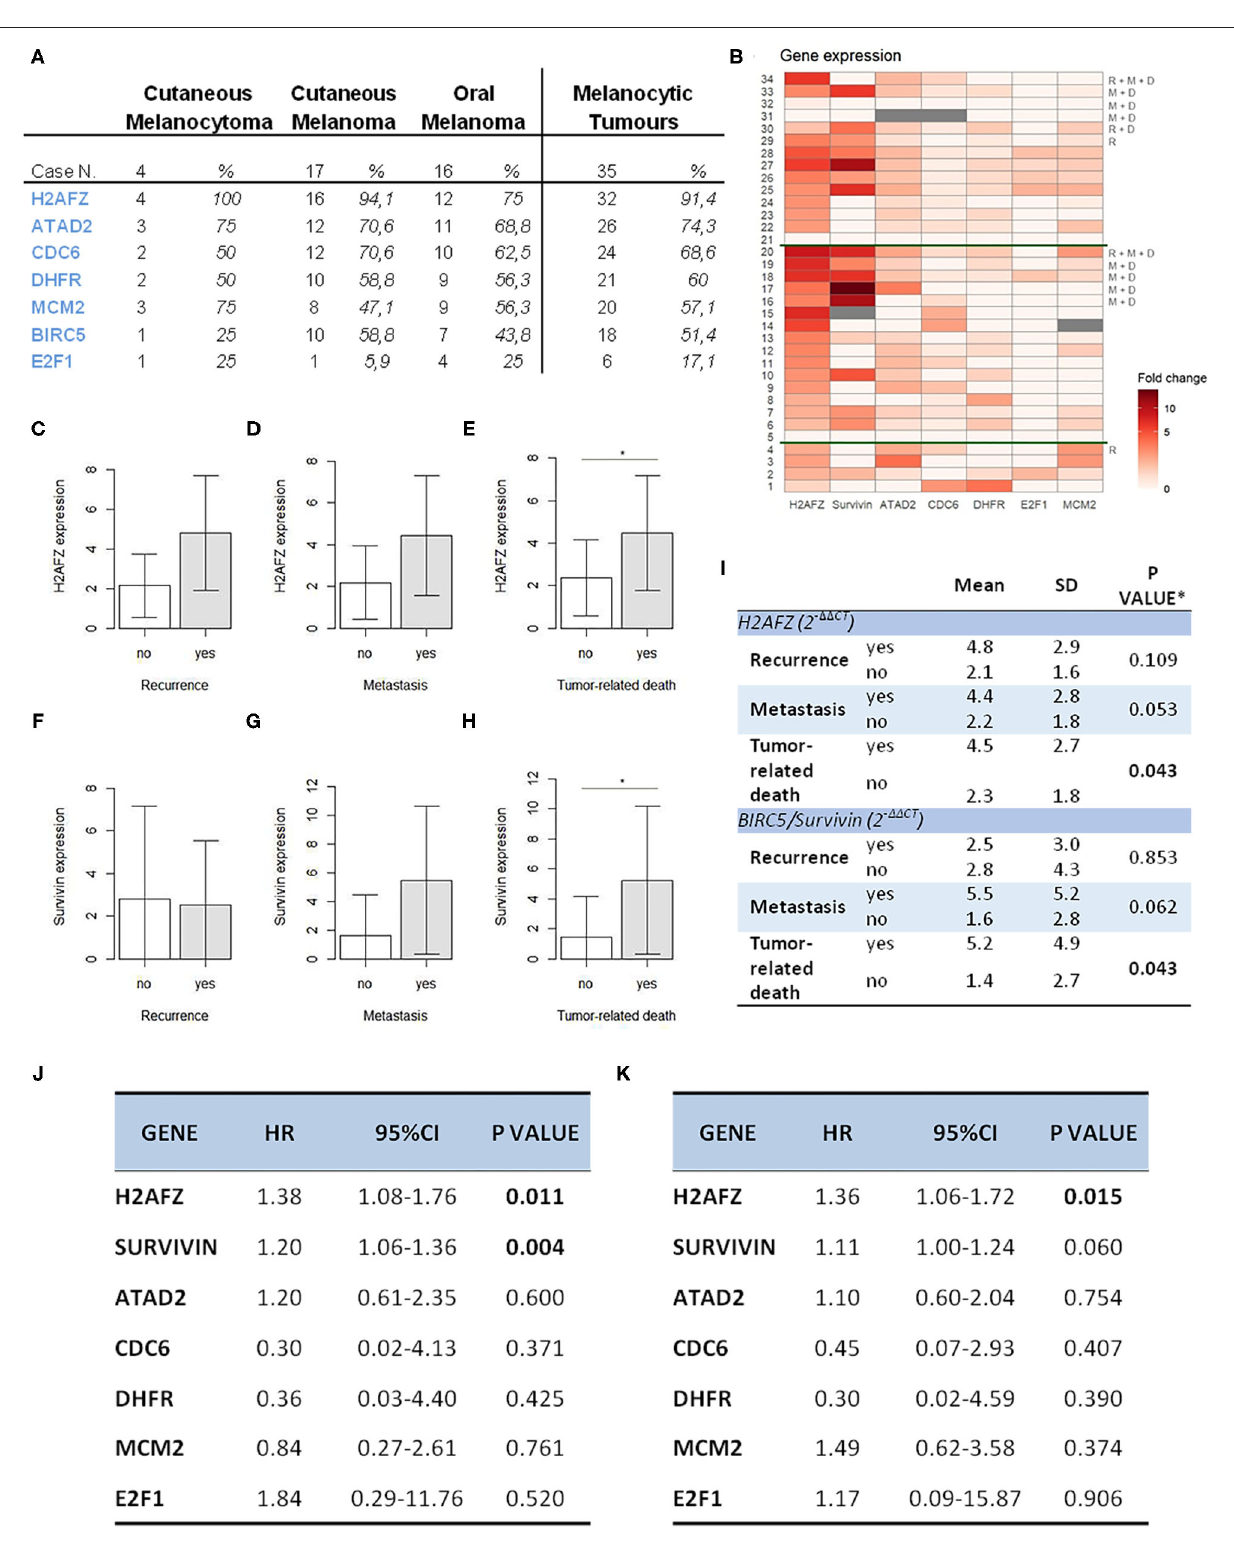
FIGURE 3 | H2AFZ and survivin/BIRC5 mRNA expressions represent prognostic factors in canine melanocytic tumors. (A) Table indicating number and percentage of positive cases for all genes in all the melanocytic tumors (right columns) and on specific types. (B) Heat map showing gene expression levels for all genes